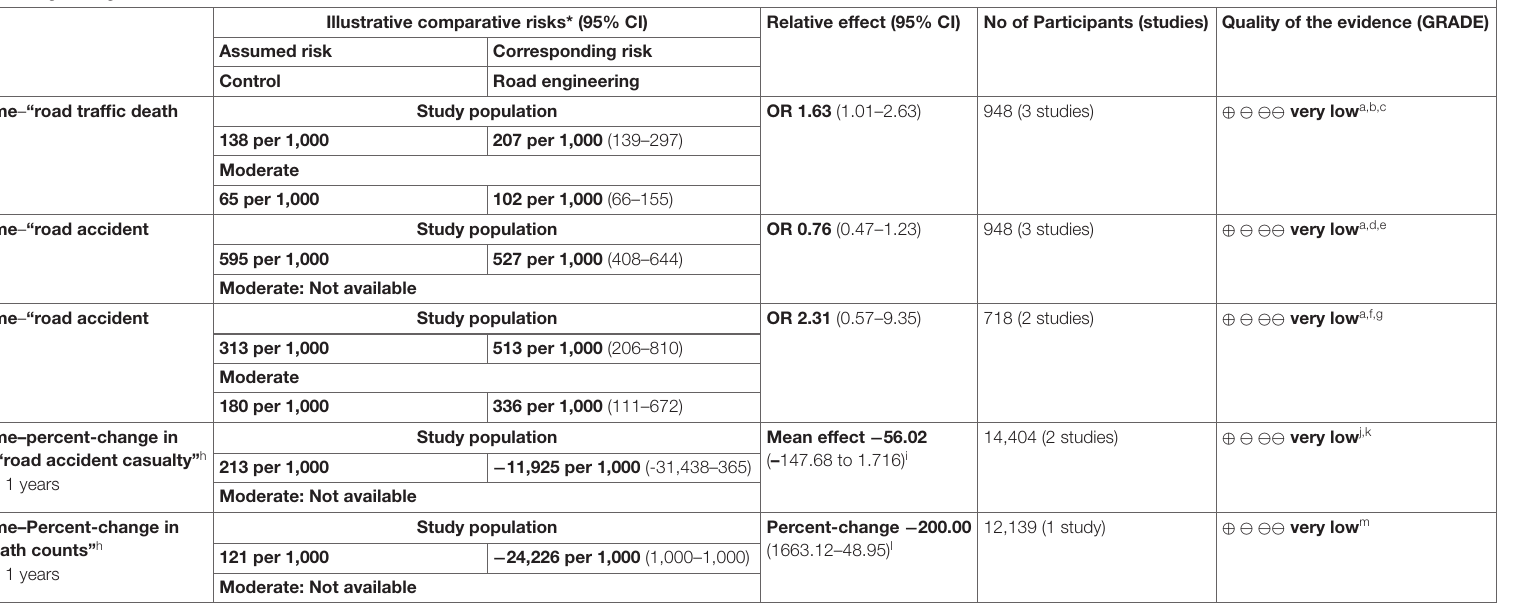
TABLE 4 | Summary of findings (GRADE) for road engineering interventions. Population: Vulnerable (non-motorized and motorized two-wheel) road users; Settings: Low- and middle-income countries Intervention: Road engineering